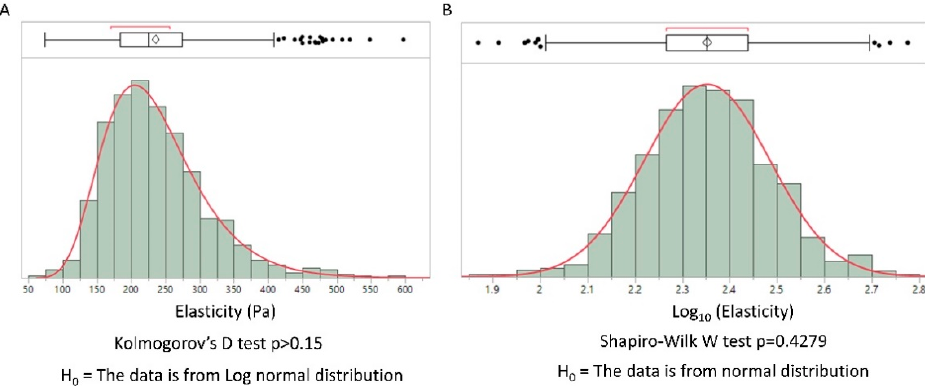
Figure 1. Distribution of elasticity values from atomic force microscopy (AFM) measurement on a collagen type I gel. ( A ) distribution values of elasticity in linear scale, a Kolmogorov’ D test for log normal distribution was performed. ( B ) The same values represented with a logarithmic scale; a Shapiro–Wilk normality test was performed. In each case we found a log-normal distribution. (Histograms were obtained using the JMP software v14.2 SAS).